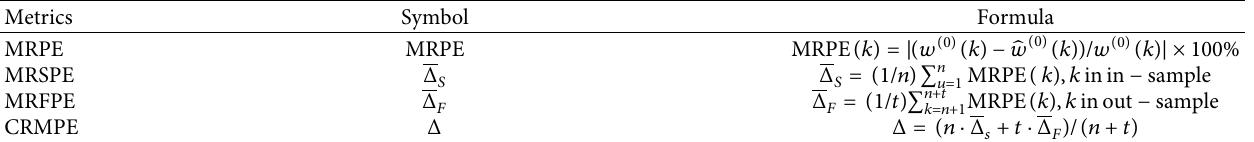
Table 4: Table model performance evaluation metrics.